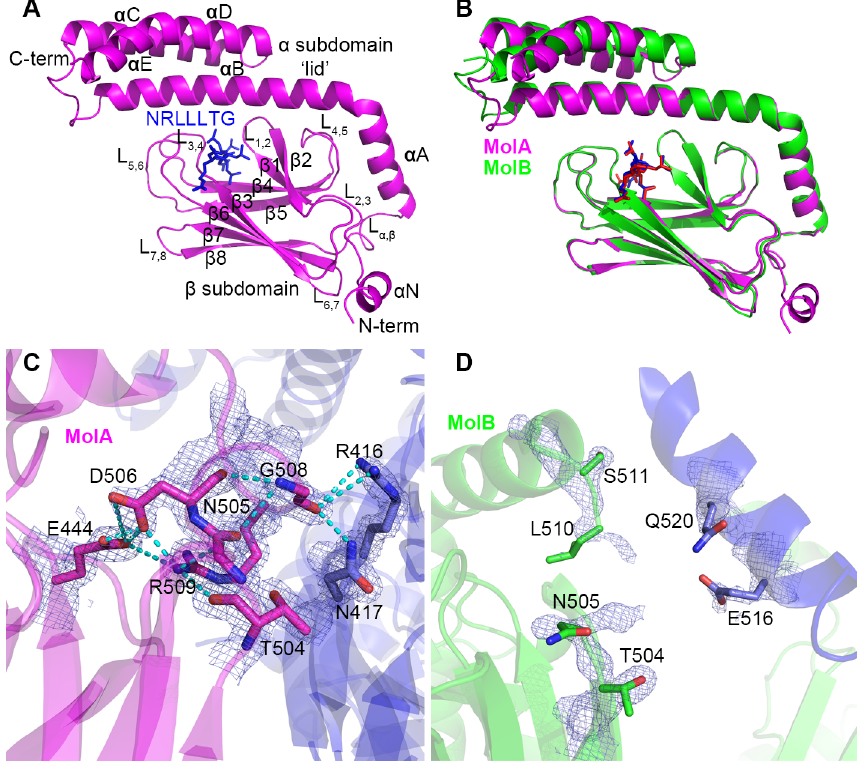
Figure 1. Overall structure of the human peptide-bound HSP70 SBD. A. Cartoon representation of NRLLLTG-bound HSP70 SBD Molecule A. The SBD and NRLLLTG peptide are shown in magenta and blue, respectively, and all domains and secondary structural elements are labeled. B. Superposition of molecules A and B in the asymmetric unit cell. Molecules A and B are color-coded magenta and green, respectively. C and D. Hinge region between the a and b subdomains. Molecules A and B are shown in panels C and D, respectively. Interacting (MolA) or potential interacting (MolB) residues are indicated in stick and CPK coloring (oxygen in red and nitrogen in blue). The electron density maps corresponding to these residues are contoured at 1.5 (MolA) and 1.0 (MolB) sigma. Hydrogen bonds are indicated with dotted